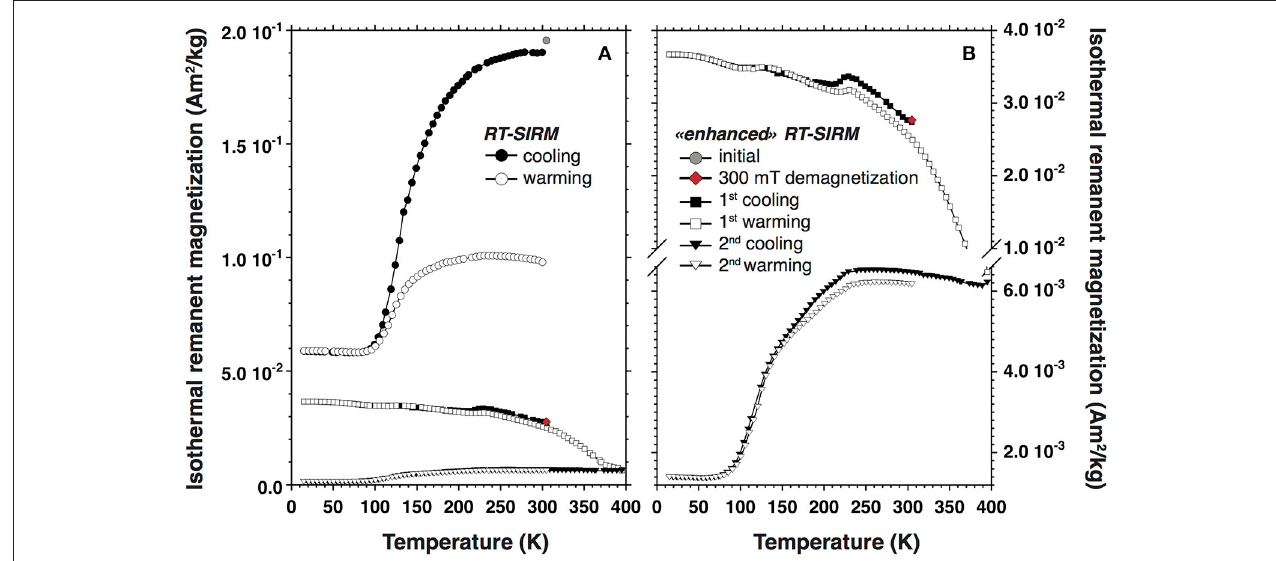
FIGURE 4 | The RT-SIRM of the mixture sample is cooled to 10K (black circles) and warmed back to 300K (white circles). An enhanced RT-SIRM is imparted by warming the sample to 400K and back to 300K in the presence of a strong 2.5 T field (gray circle). The enhanced RT-SIRM is demagnetized by charging the supraconducting magnet in the no-overshoot mode to 300 mT and back to zero in the oscillation mode and measured (red diamond). The 300 mT demagnetized enhanced RT-SIRM is cooled to 10K (black squares) and warmed to 400K (white squares), providing a partial thermal demagnetization before cooling back to 10K (solid triangles) and warming to 300K (white triangles). The full experiment is shown in (A) . (B) Provides a broken zoomed scale of the first and second cycling of the enhanced and partially demagnetized RT-SIRM. MPMS sequence is provided in Supplementary Material.